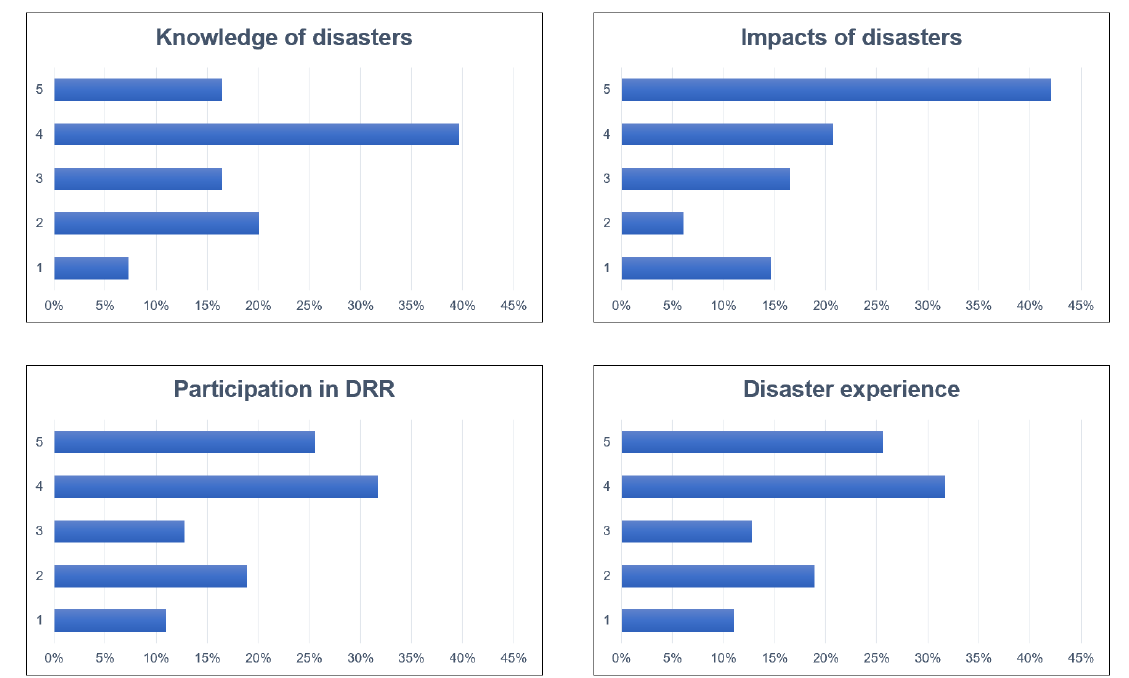
Figure 6. Statistic distribution of each variable of risk perception (1 = strongly disagree, 2 = disagree, 3 = neutral, 4 = agree, 5 = strongly agree).